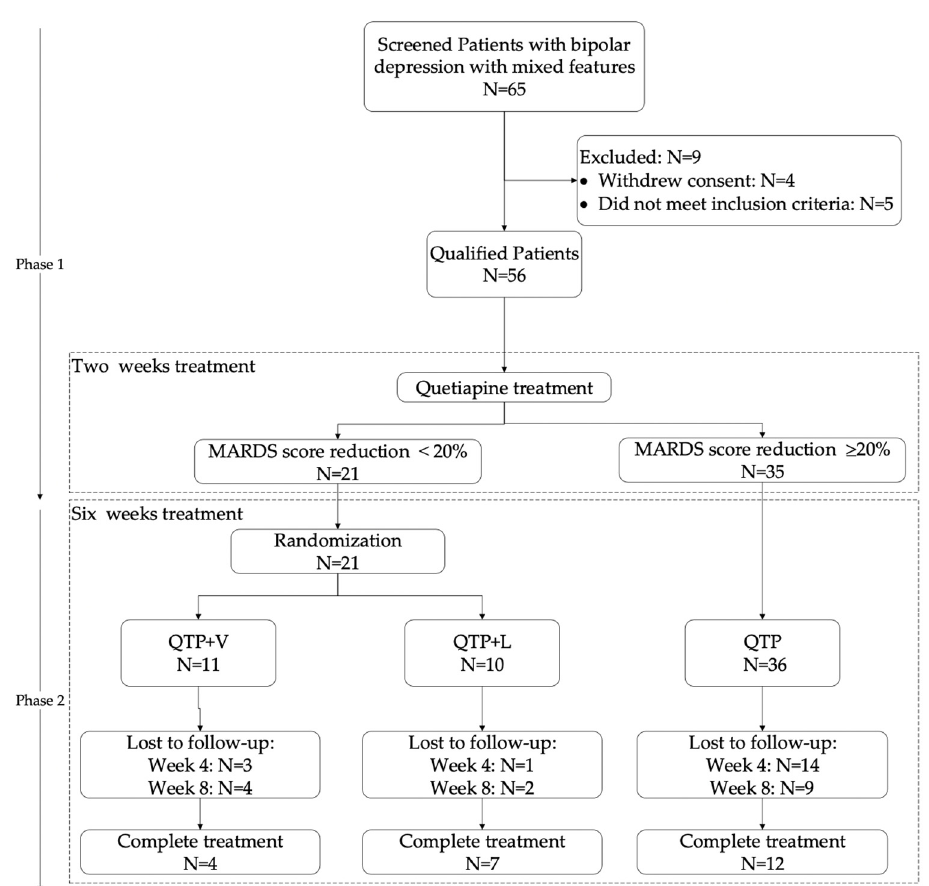
Figure 1. Enrolment and randomization. Table 1. Characteristics of the enrolled patients *.